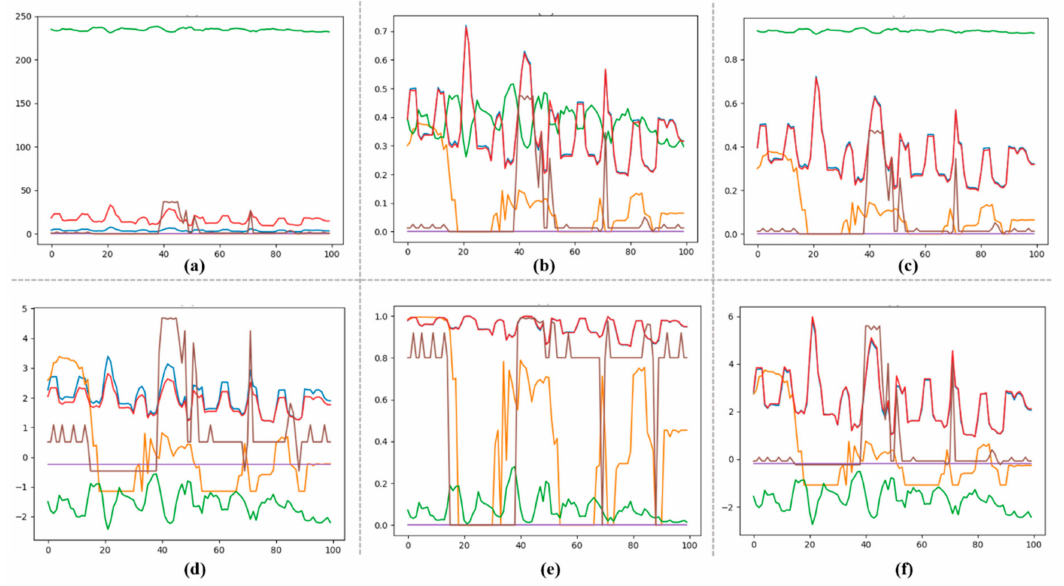
Figure 2. Data normalization techniques, where ( a ) original data in the dataset, ( b ) the range of data after applying Min-Max scalar, ( c ) the range of data after applying Max-Abs scalar, ( d ) the range of values after applying power transform, ( e ) the data plot after quantile transformation, and ( f ) the range of data after applying standard